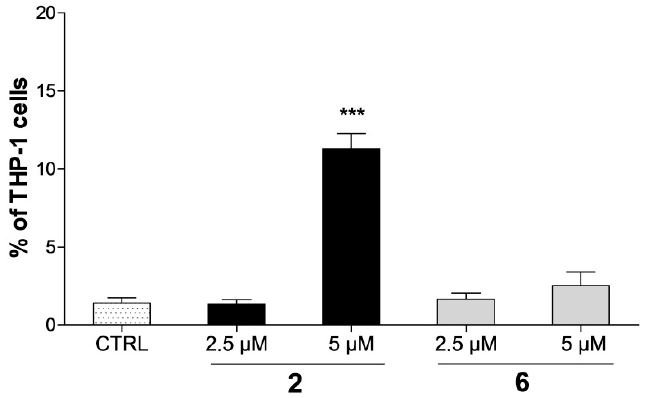
Figure 4. Compound 2 causes a significant increase of hypodiploid sub-G1 peak in THP-1 cells. Quantification of the sub-G1 peak in THP-1 cells after the treatment by compounds 2 and 6 for 24 h. The results are expressed as the means ± SD of three independent experiments. *** p < 0.001, statistically significant difference in comparison with the drug-free control (CTRL).